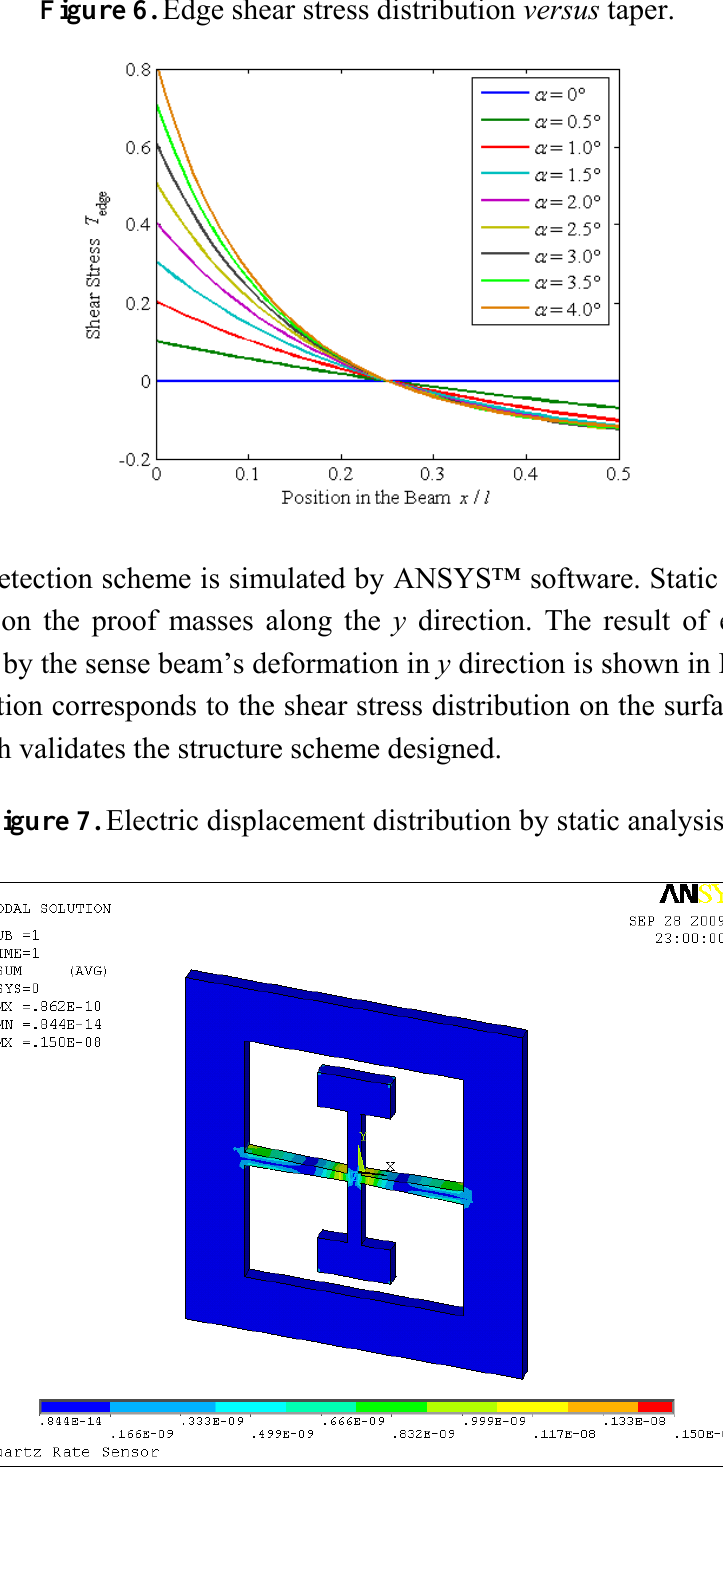
Figure 6. Edge shear stress distribution versus taper.